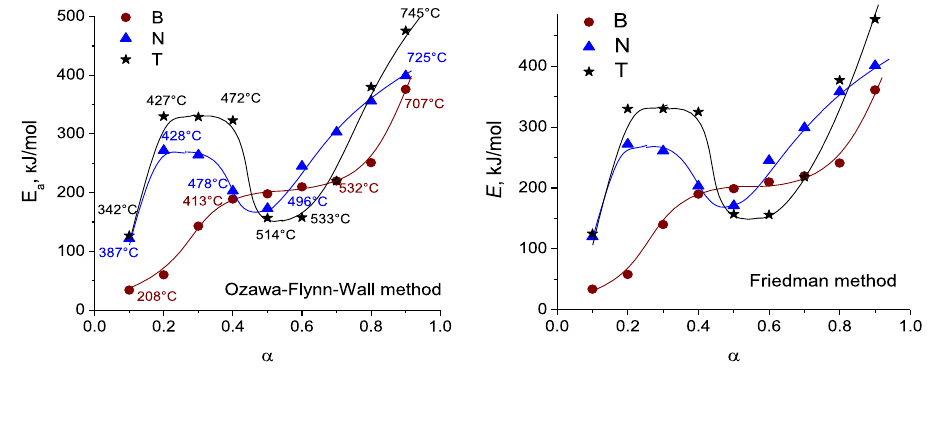
Fig. 8 The plot of activation energies calculated by Ozawa– Flynn–Wall and Friedman methods for pyrolysis of differ- ent coals vs coal conversion